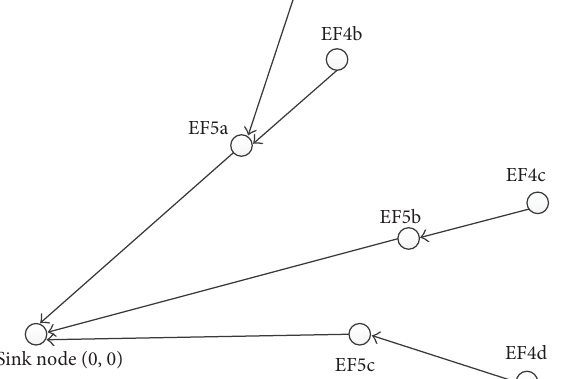
Table 2: The average energy consumption when the first node is